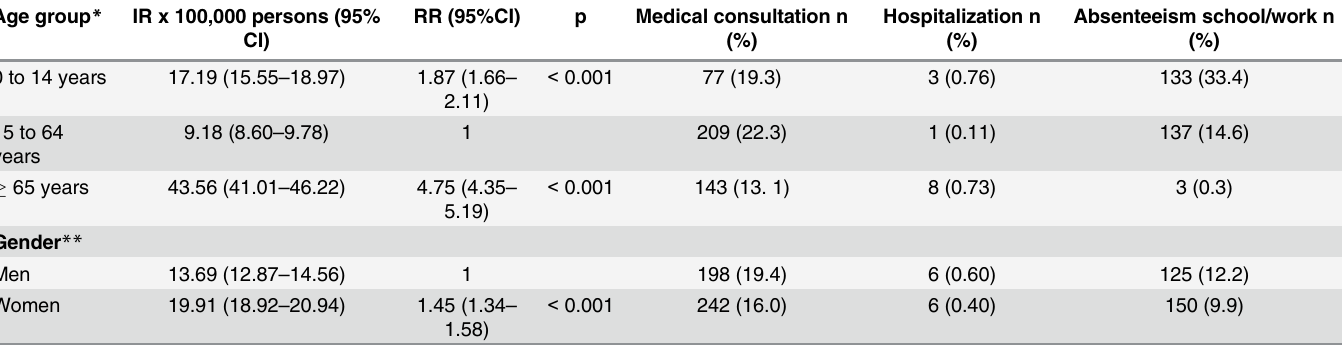
Table 2. Incidence rates and risk ratio of infection, hospitalization rates, medical consultation and absenteeism according to age groups and gen- der. Catalonia 2010 –